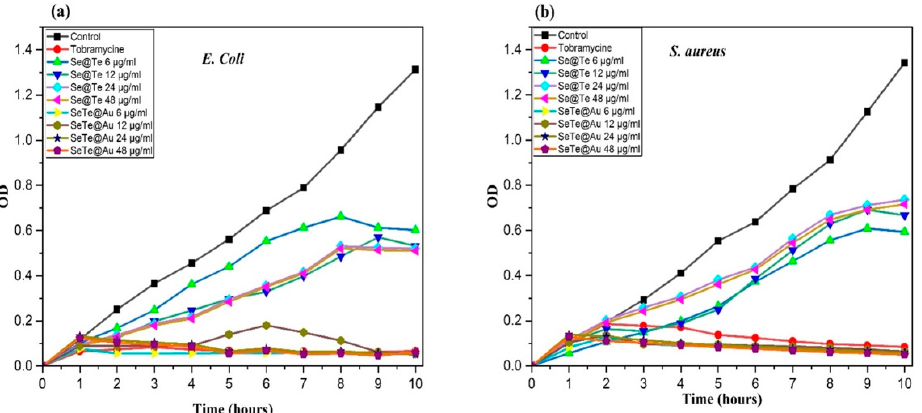
Figure 5. Growth curves of bacterial cells ( a ) E. coli ( b ) S. aureus exposed to different concentrations of Se-Te and Se-Te@Au.